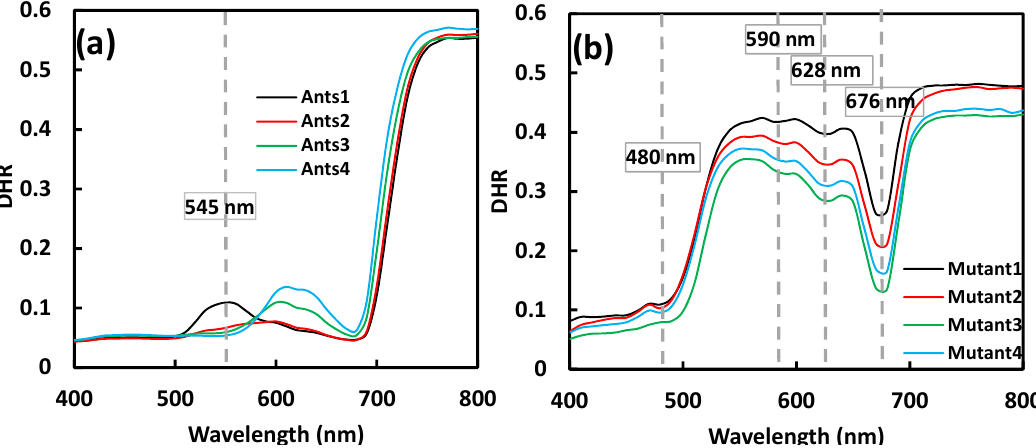
Figure 5. Leaf reflectance spectra reveal the in vivo pigment-specific absorption characteristics. Spectra are from ( a ) Red Robin leaves from ZJU with different Ants content (Ants1 = 2.379 μ g/cm 2 ; Ants2 = 3.997 μ g/cm 2 ; Ants3 = 6.117 μ g/cm 2 ; and Ants4 = 11.036 μ g/cm 2 ), and ( b ) is from the report [28]. DHR is leaf directional hemispherical reflectance.